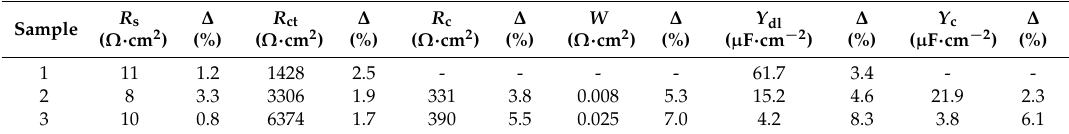
Table 1. Fitted electrochemical parameters ( Δ referring to fitting error) of Al alloy substrate (Sample 1), modified substrate (Sample 2) and modified deposited sample (Sample 3).